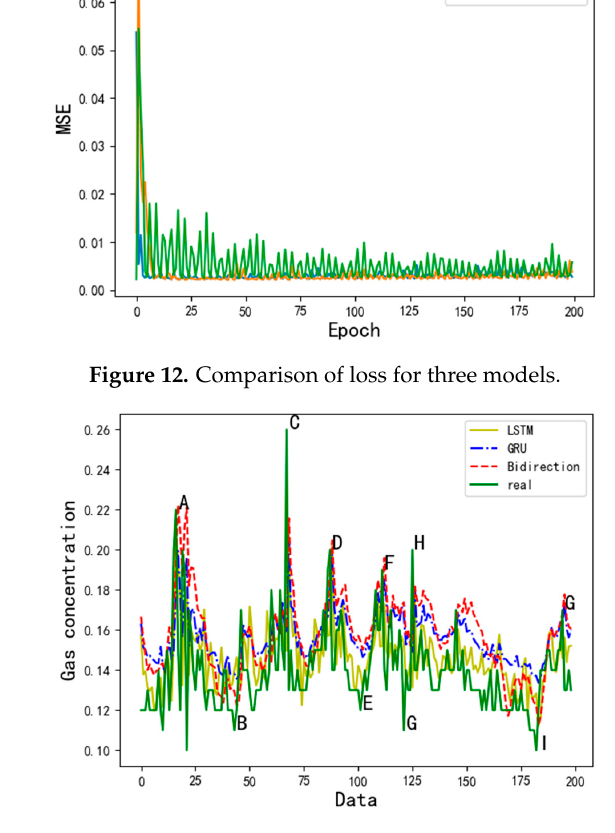
Figure 13. Comparison of test results for three models.